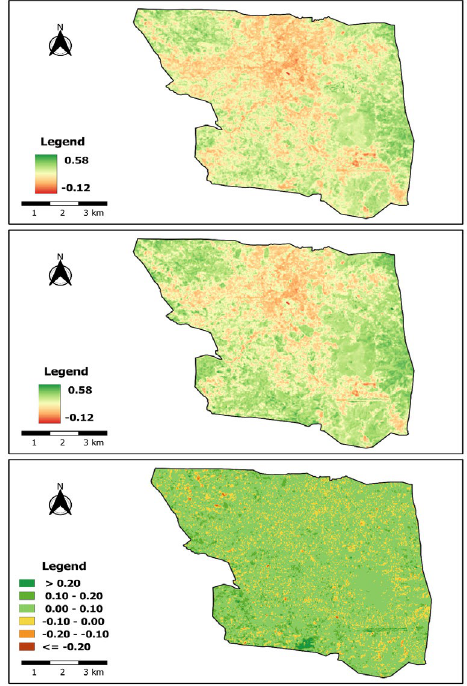
Figure 2. Spatial distributions of NDVI in Baguio City in 2019 (top) and 2022 (middle), and the difference (bottom). The figure illustrates that the grassland and agriculture areas in the current year are substantially greener than they were in 2019.